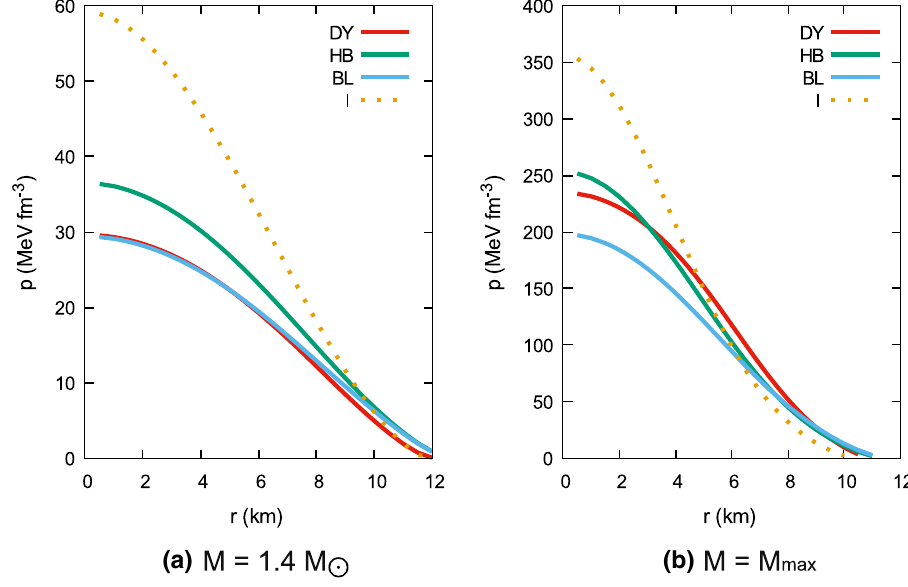
Fig. 2 Radial pressure of anisotropic models NSs and its isotropic (I) for M = 1 . 4 M (cid:6) and M = M